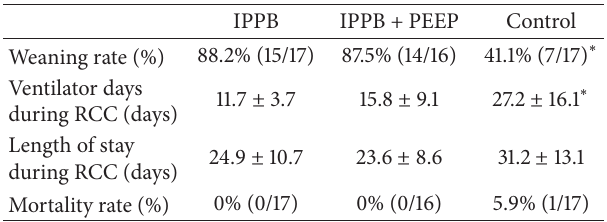
Table 4: Comparison of hospitalization outcomes between